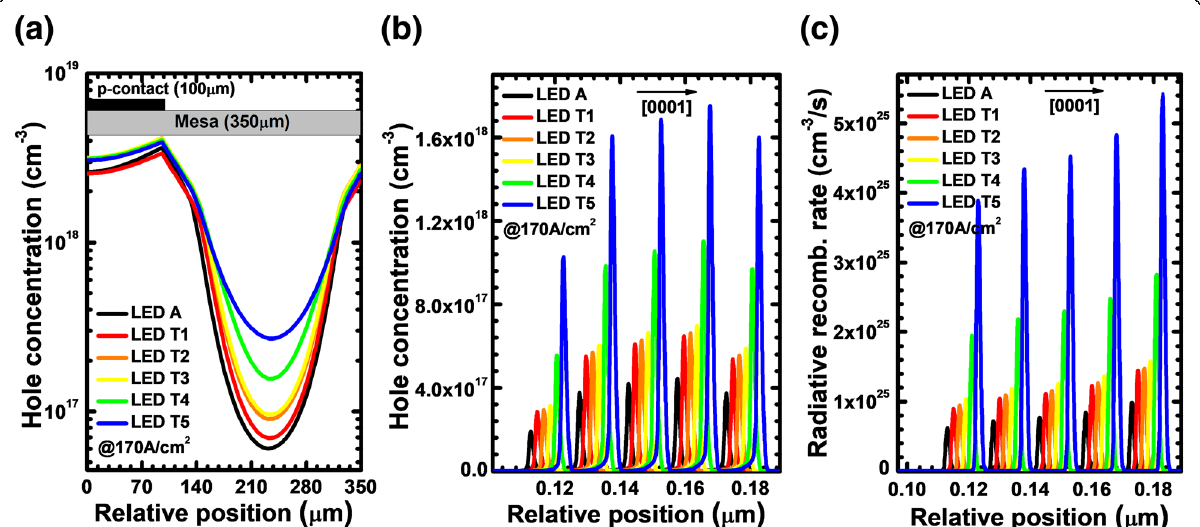
Fig. 6 a Lateral hole distribution in the last quantum well, b hole concentration profiles and c radiative recombination rate profiles in the MQW region for LEDs A, T1, T2, T3, T4, and T5 at the current density of 170 A/cm 2 . The plotted curves for panels b and c are purposely shifted by 2 nm for better resolution